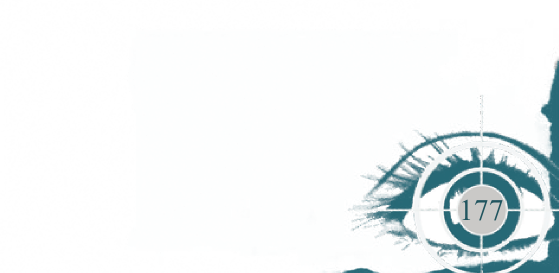
The South African Optometrist